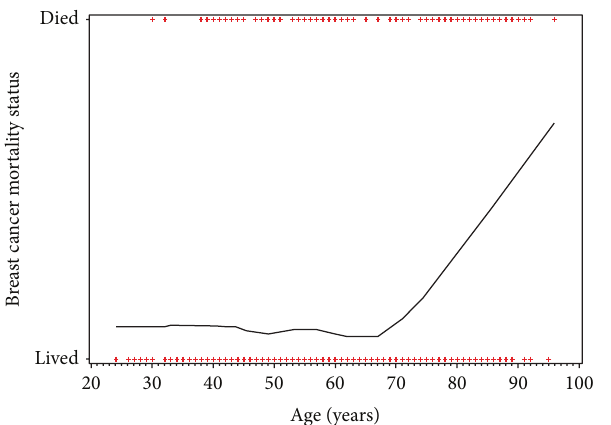
Figure 2: Breast cancer mortality by stage of diagnosis shows a correlation between late stage of diagnosis and increased mortality